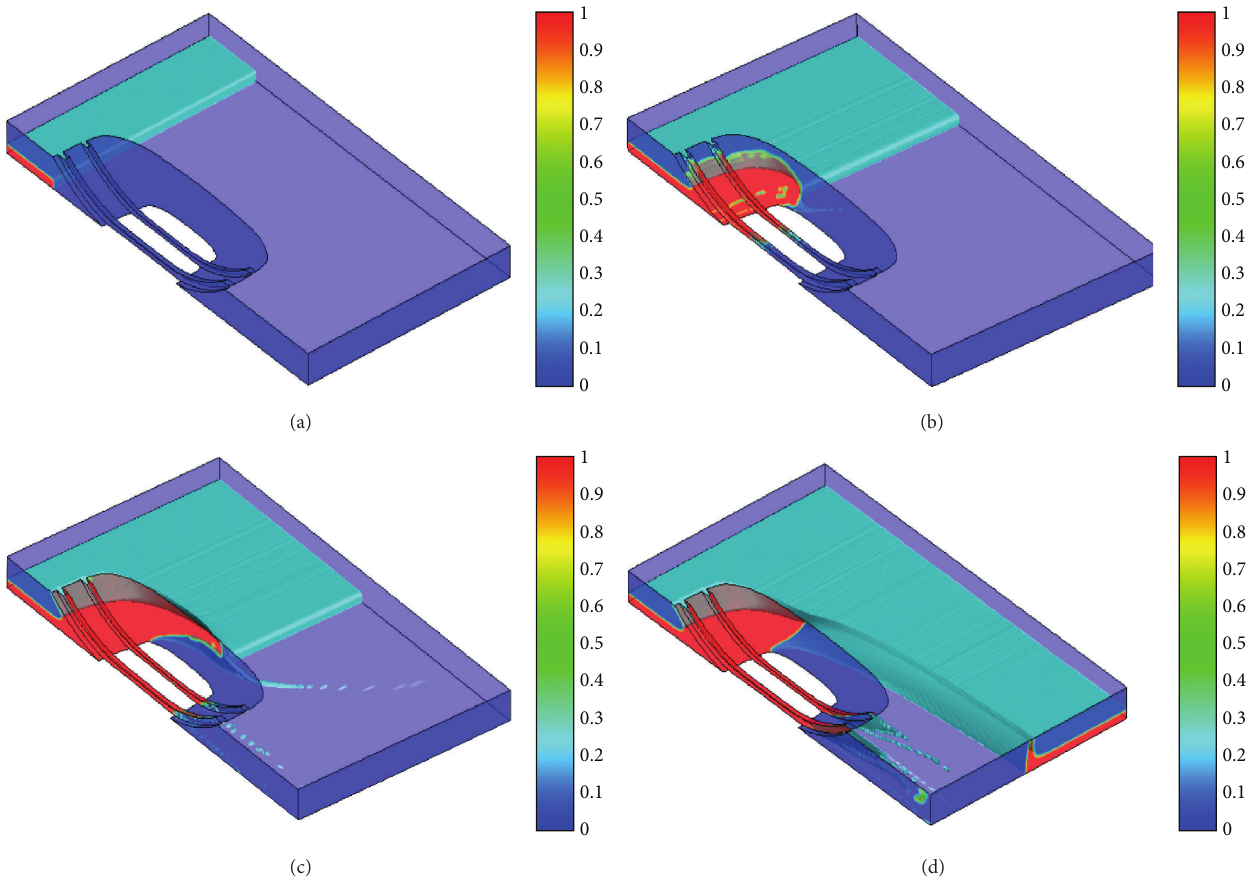
Figure 4: Free surface of water in tire hydroplaning at different times: (a) 𝑡 = 0.005 s; (b) 𝑡 = 0.01 s; (c) 𝑡 = 0.015 s; (d) 𝑡 = 0.04